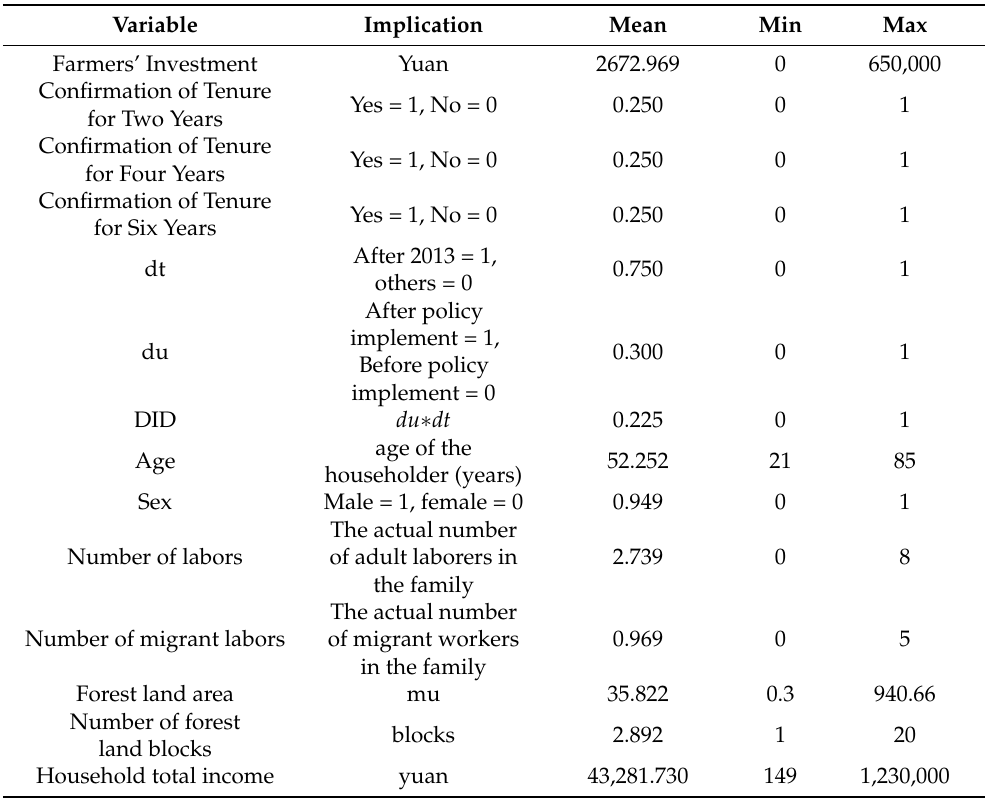
Table 1. Variable selection and descriptive